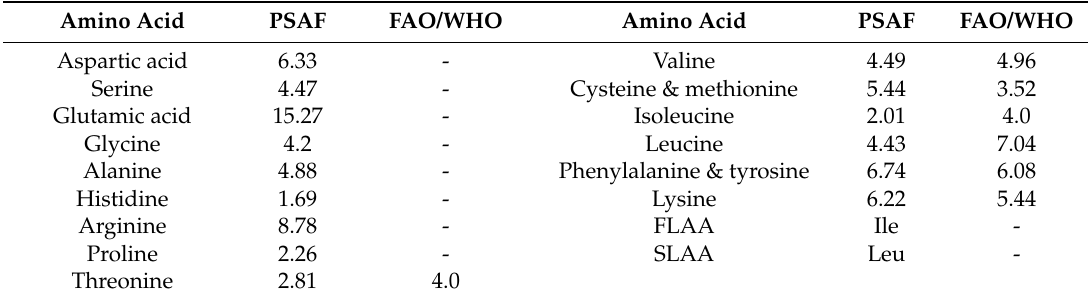
Table 2. Analysis of amino acids composition (mg/100 mg) of